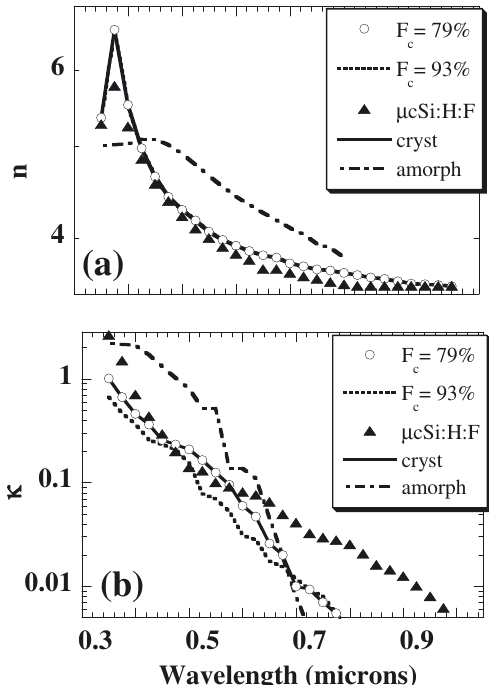
Fig. 2. Values of the complex refractive indices (a) real part, n and (b) imaginary part, κ for low (79%), interme- diate (93%) crystalline volume fraction ( F c ) μ c-Si:H, and for μ c-Si:H:F, F ∼ 100%, compared to the respective values of a- c Si:H (amorph) and c-Si (crys).